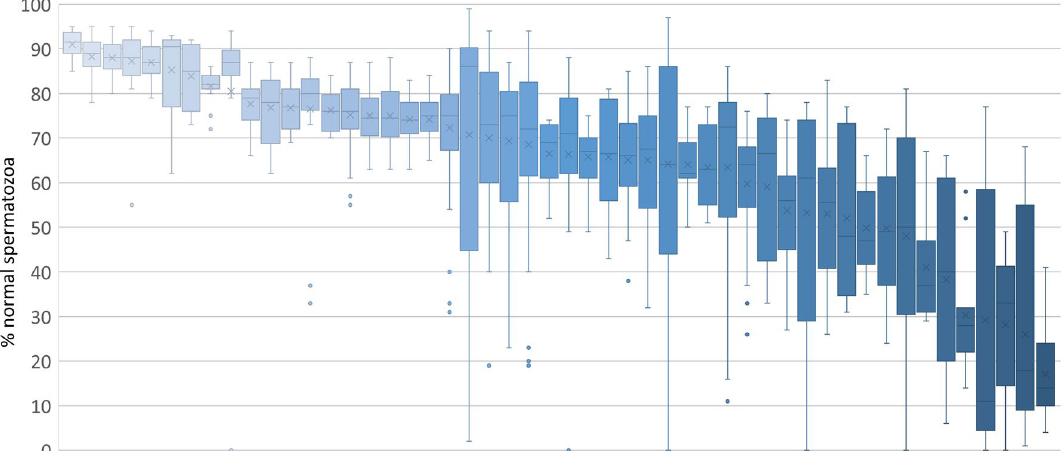
Figure 1. Changes in sperm normal forms. Semen samples were taken from bulls via electroejaculation and the percentage sperm normal forms were counted. The data show a box and whiskers plot consisting of 50 bulls, each of which had at least 5 different ejaculates across a minimum one month. Each box and whiskers plot represents an individual Bull showing the median, upper and lower quartile range. Outliers are represented by individual